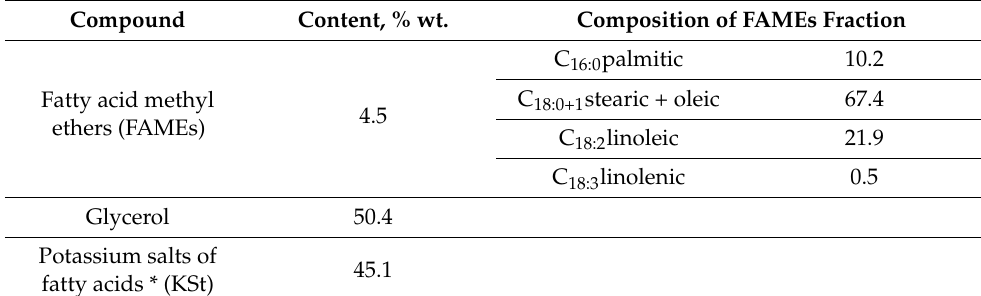
Table 1. Composition of crude